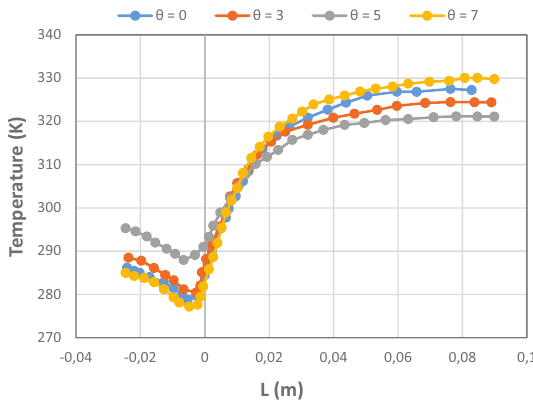
Figure 14. A diagram of temperature versus the length of the vortex tube for axial angle inlet nozzles of θ = 0°, 3°, 5° and 7°